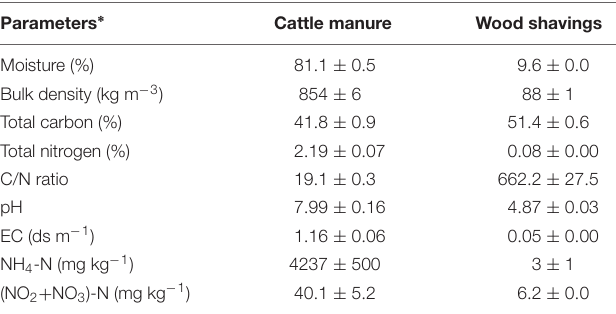
TABLE 1 | Physicochemical characteristics of materials included in matrices used for laboratory composting under both non-containment and containment